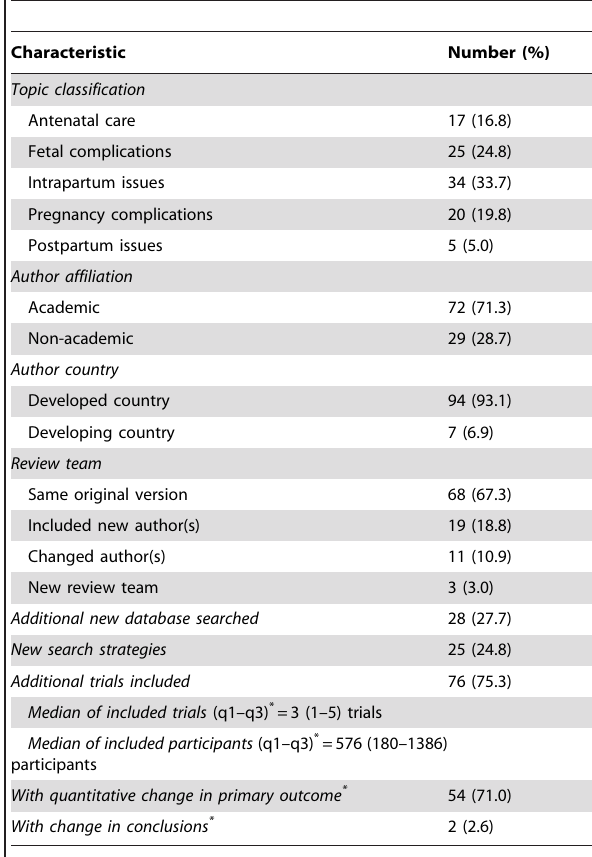
Table 1. Characteristics of updated reviews at first update period (101